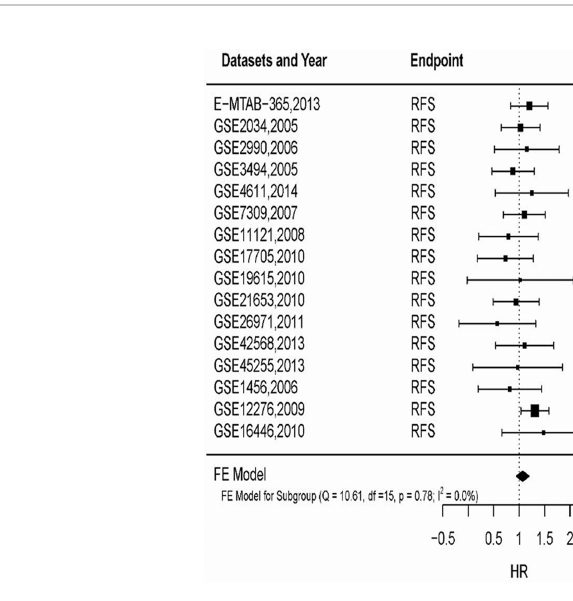
description of the exact location of the sample on tumor in the lesion may be associated with different results.